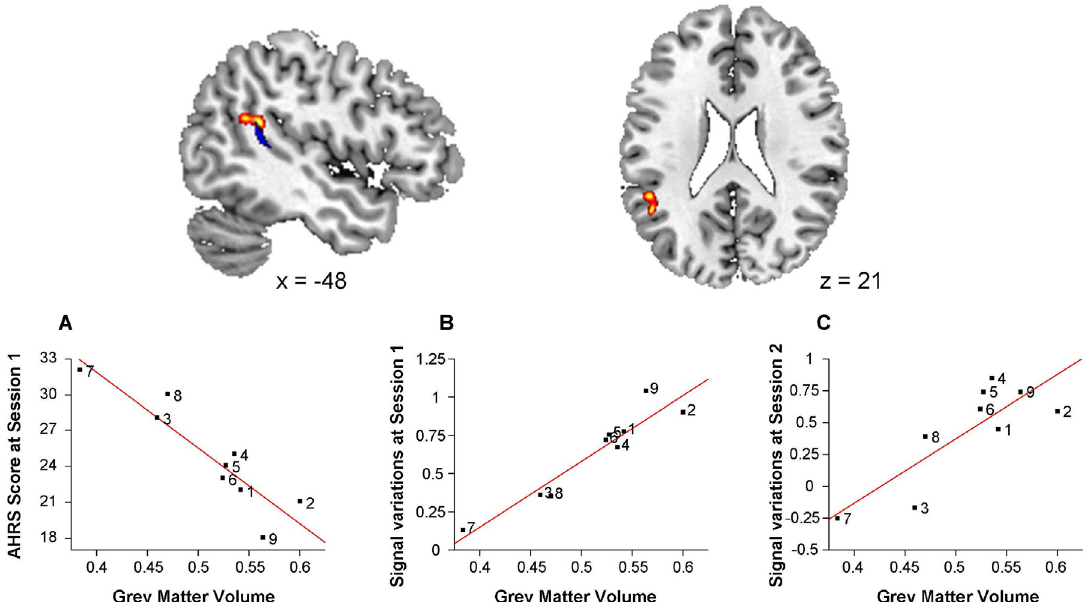
Figure 4. Negative correlation between grey matter volume and baseline Auditory Hallucination Rating Scale (AHRS) scores in schizophrenia